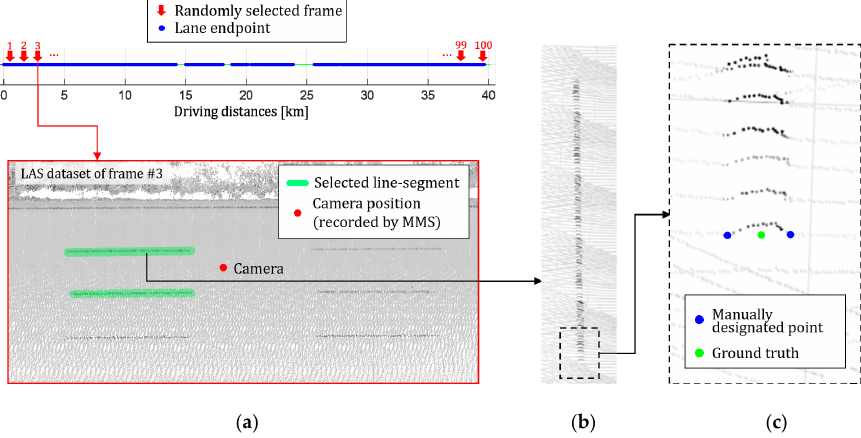
Figure 9. Ground truth acquisition procedure. ( a ) 3D points around the selected camera position; ( b ) Enlargement of dashed lane segment; ( c ) Lane endpoint ground truth designation.